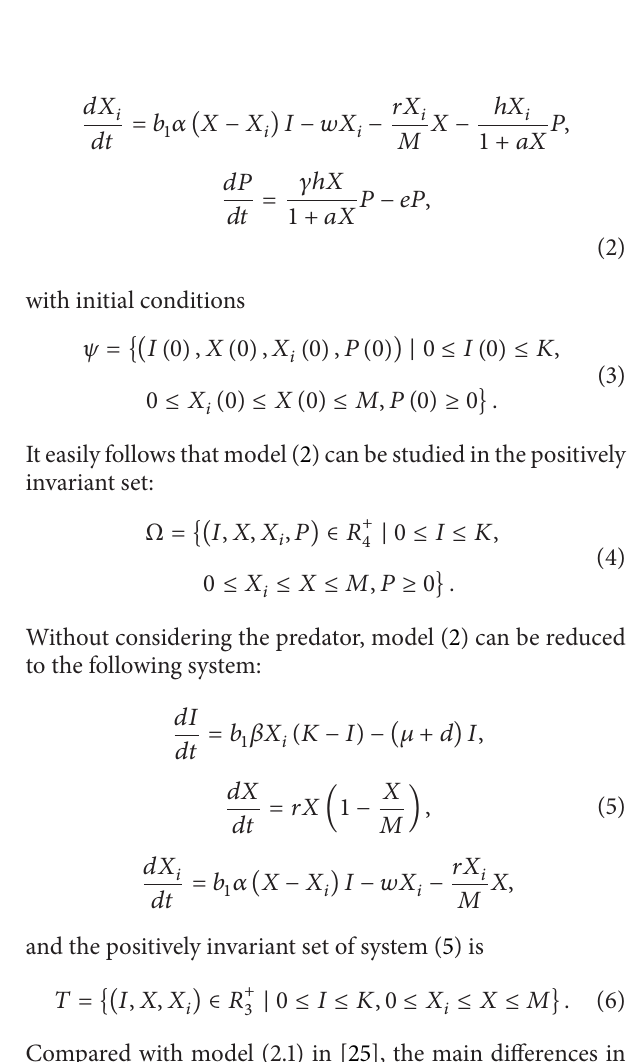
Figure 1: Flow chart of the host-vector-predator